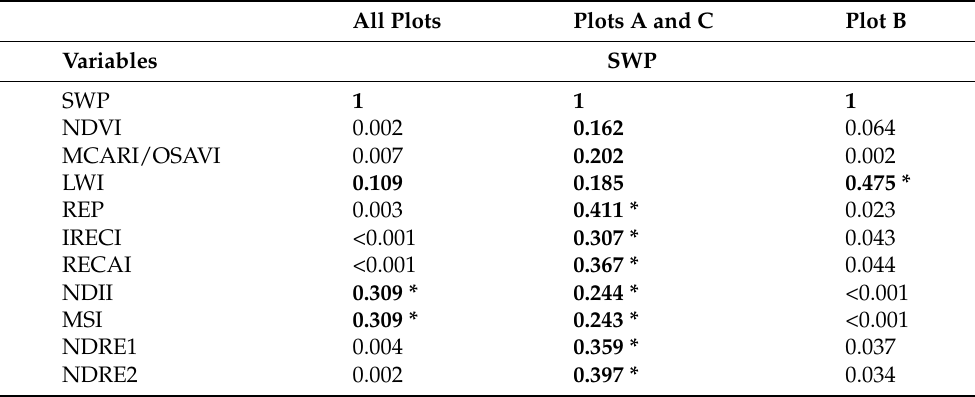
Table 11. Coefficient of determination between MVI and SWP (values in bold are different from 0 at significance level alpha = 0.05). All Plots Plots A and C Plot